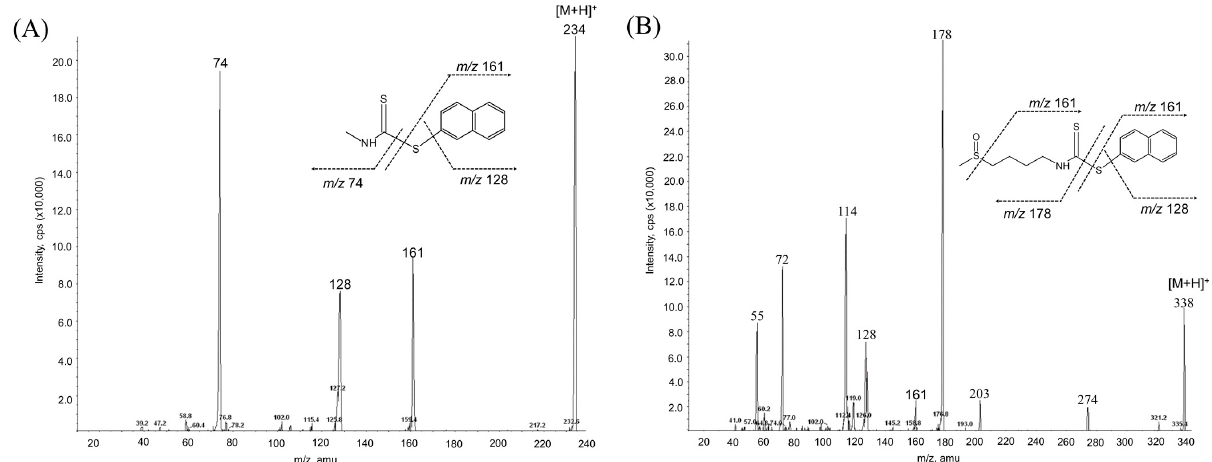
Figure 3. MS/MS spectra of 2-NT-SFN ( A ) and 2-NT-IS ( B ) obtained by ESI in positive mode using a collision energy of 30 eV. IS, internal standard; SFN, sulforaphane; 2-NT, 2-naphthalenethiol.